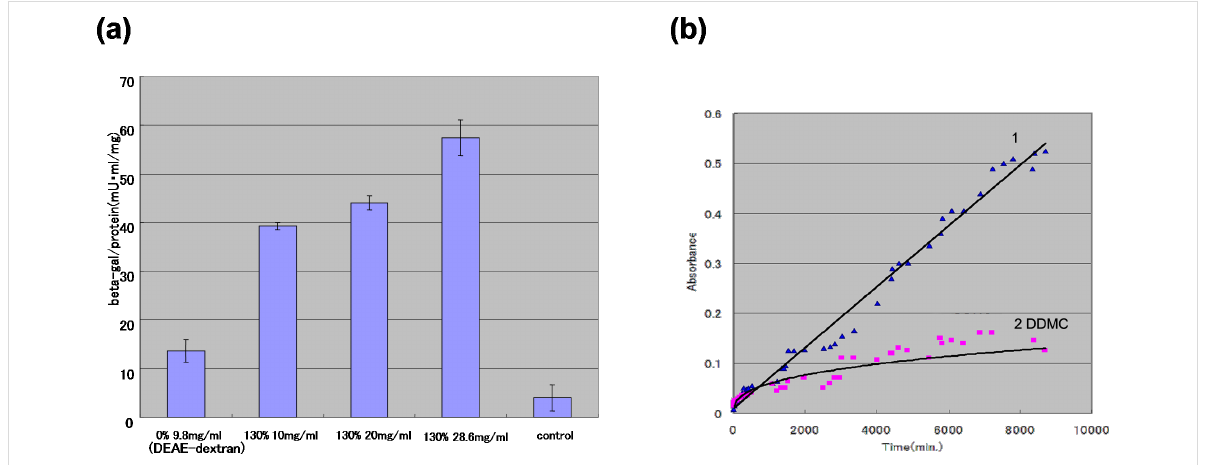
Figure 1: Non-viral vectoring of DEAE–dextran and DEAE–dextran–MMA graft copolymer (DDMC). (a) Transfection of DDMC into HEK293 cell lines. The grafting rate is 130% for sample 2 at 10 mg/mL, sample 3 at 20 mg/mL, and sample 4 at 28.6 mg/mL. Expression of the LacZ gene is shown at 48 h after transfection. (b) DNase degradation (1: DEAE–dextran, 2 DDMC): To the samples was added 4 mL of distilled water, then 10 u of DNase (RQ1 RNase-free DNase, Promega) and 0.1 mL of 10× reaction buffer (400 mM Tris-HCl, 100 mM MgSO 4 , 10 mM CaCl 2 , pH 8) and the samples were incubated at 37 °C. The wavelength used for this experiment was 633 nm for toluidine blue isolated from DNA. (b): Reprinted from